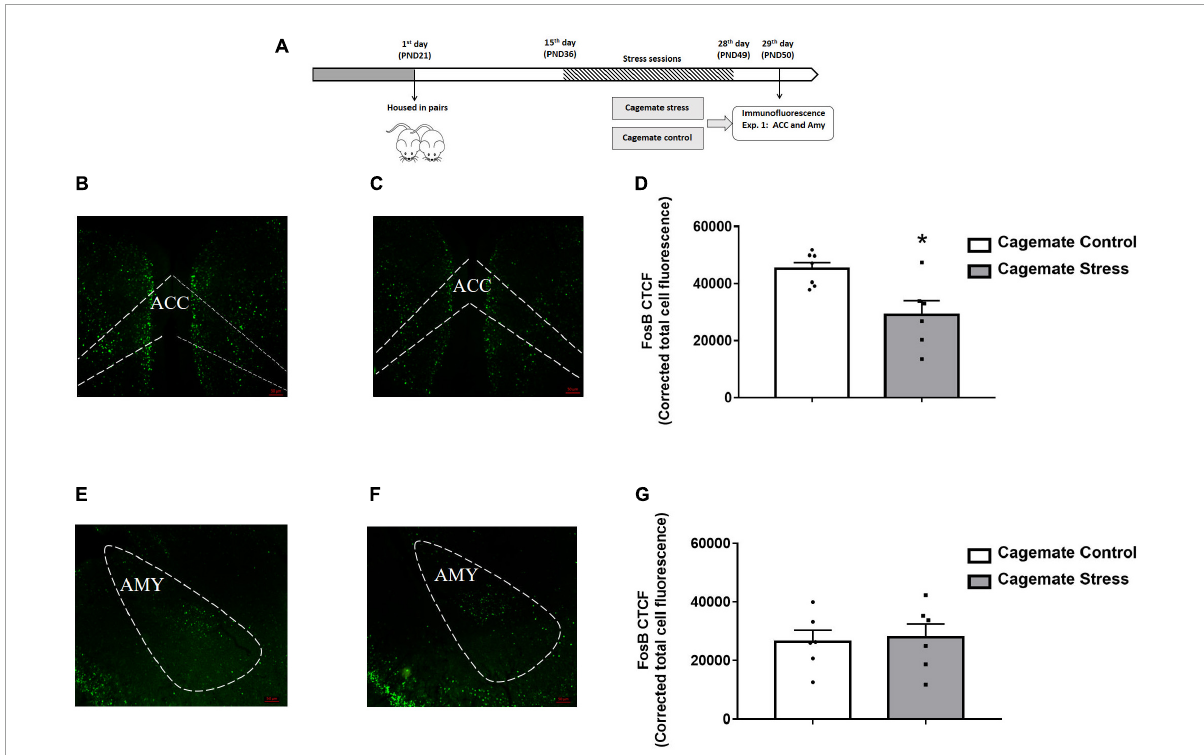
FIGURE1 (A) Schematic representation of the experimental protocol (PND, postnatal day). (B,C) Representative photomicrographs of the anterior cingulate cortex (ACC) showing Fos-positive labeled cells in cagemate control and cagemates stress, respectively. (D) Number of Fos-positive labeled cells per corrected total cellular fluorescence of the ACC in cagemates that cohabited in pairs with mice subjected to chronic restraint stress compared to cagemate control. (E,F) Representative photomicrographs of the amygdala showing Fos-positive labeled cells in cagemates control and cagemates stress, respectively. (G) Number of Fos-positive labeled cells per corrected total cellular fluorescence of the amygdala in cagemates that cohabited in pairs with mice subjected to chronic restraint stress compared to cagemate control. All data are presented as mean ± SEM ( n = 6–7). * p < 0.05 vs. respective cagemate control group. Student t -test. Amy,